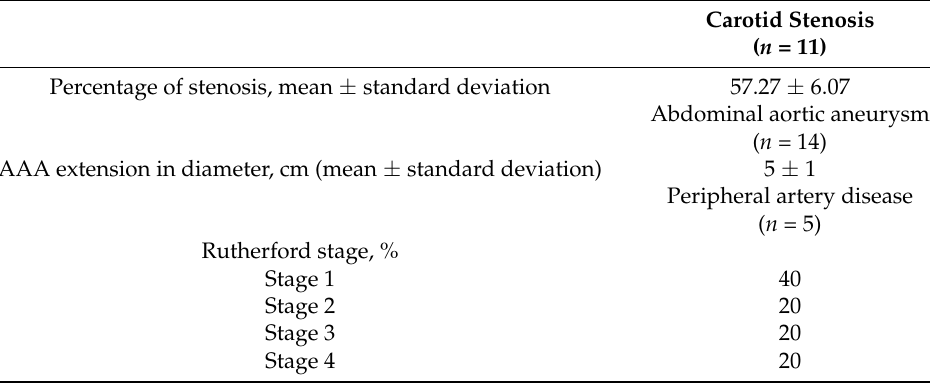
Table 2. Particular characteristics of each artery disease